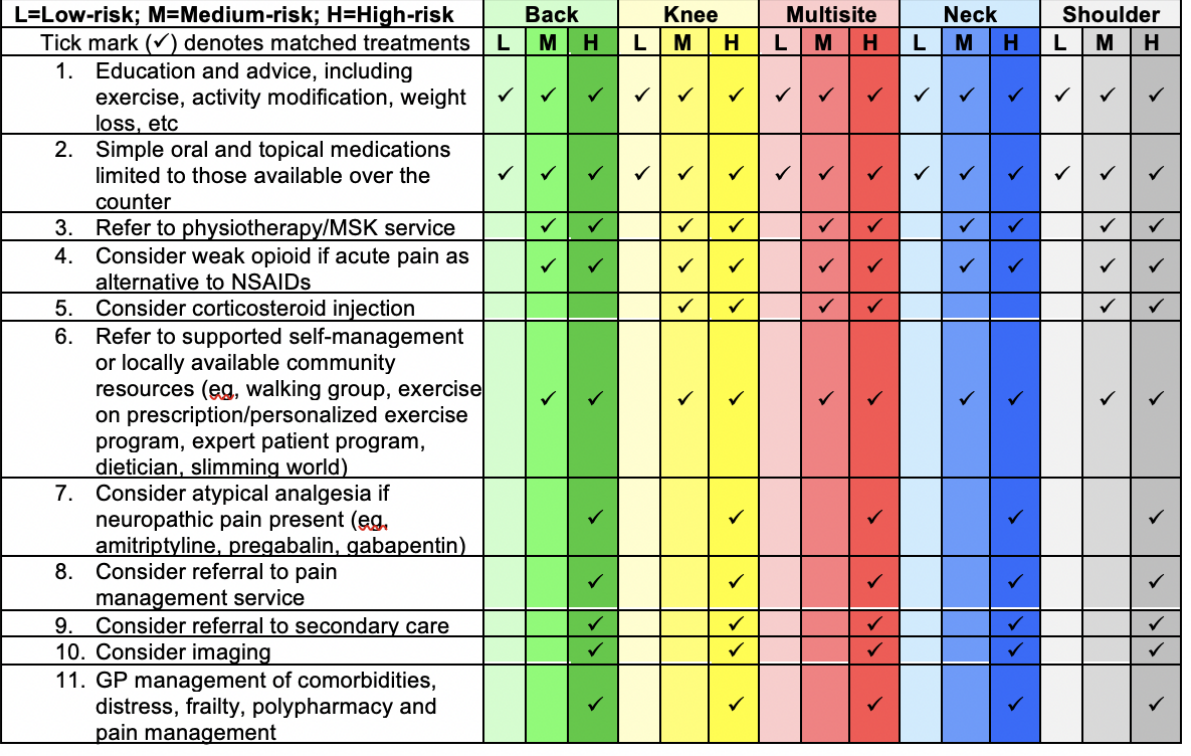
The matched options for patients at low risk include advice